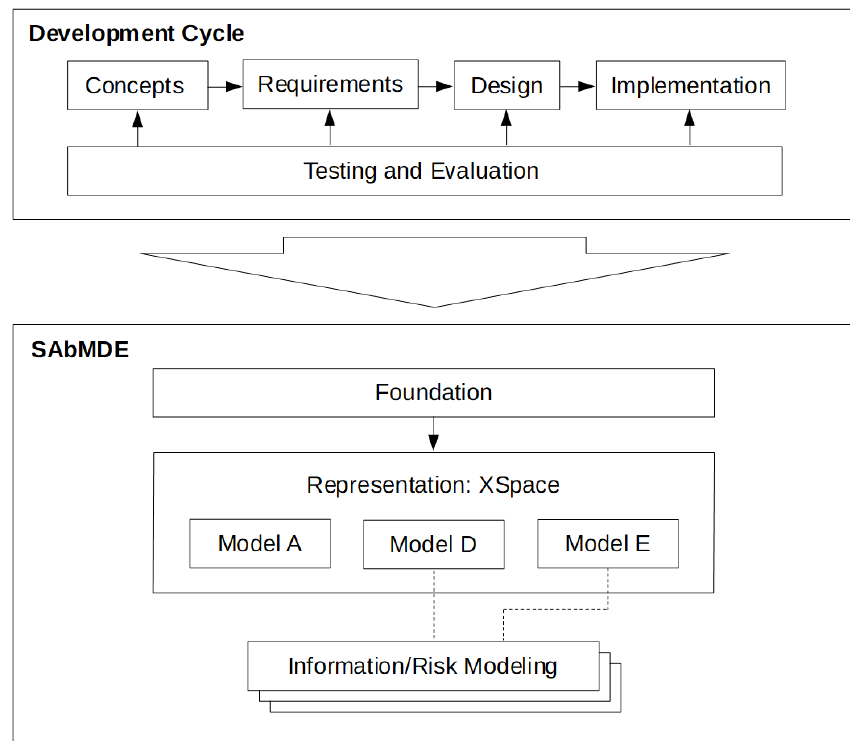
Figure 1. Development modeling